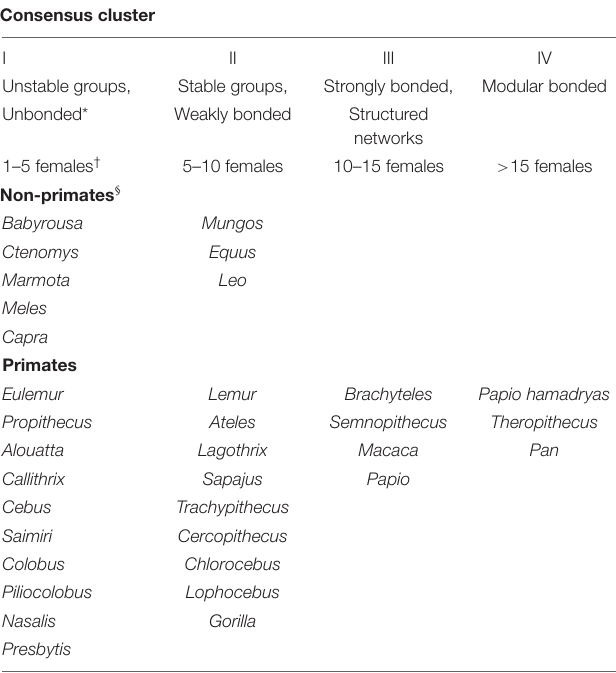
TABLE 2 | Consensus cluster allocations of mammalian genera by k- means cluster analysis of optimal number of females to maximise fecundity and fertility (see Supplementary Table 5 ) for species with stable social groups